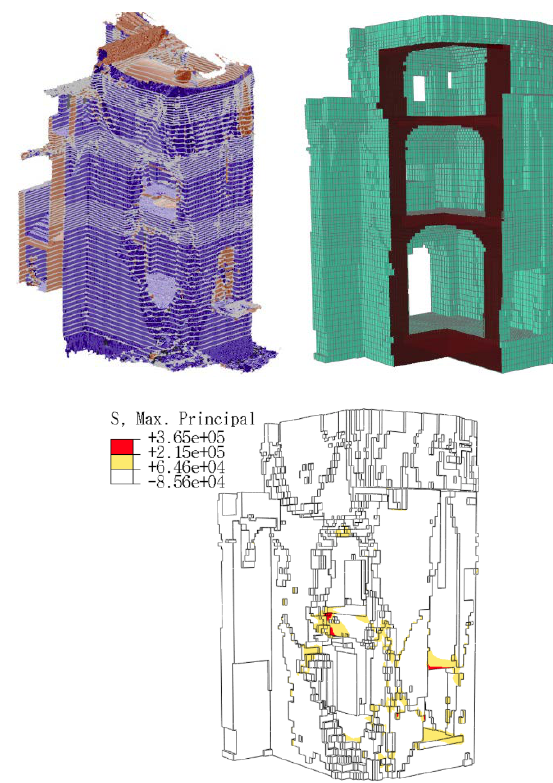
Figure 3. From point clouds to FEM using CLOUD2FEM procedure (Castellazzi et al., 2015) on a historical building: mesh with slices at variable distance (top left), voxel model (top right) and one result of structural analysis (bottom).